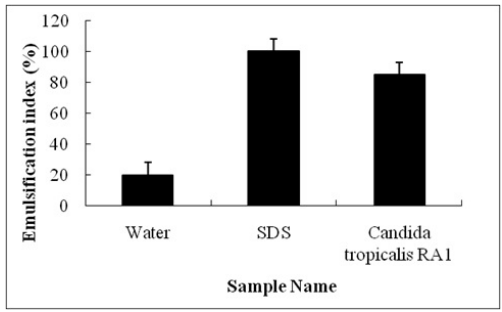
Fig. 4. Emulsification index analysis of 240 h fermented broth of Candida tropicalis RA1. The study includes 0.1% SDS and water used as a positive and negative control